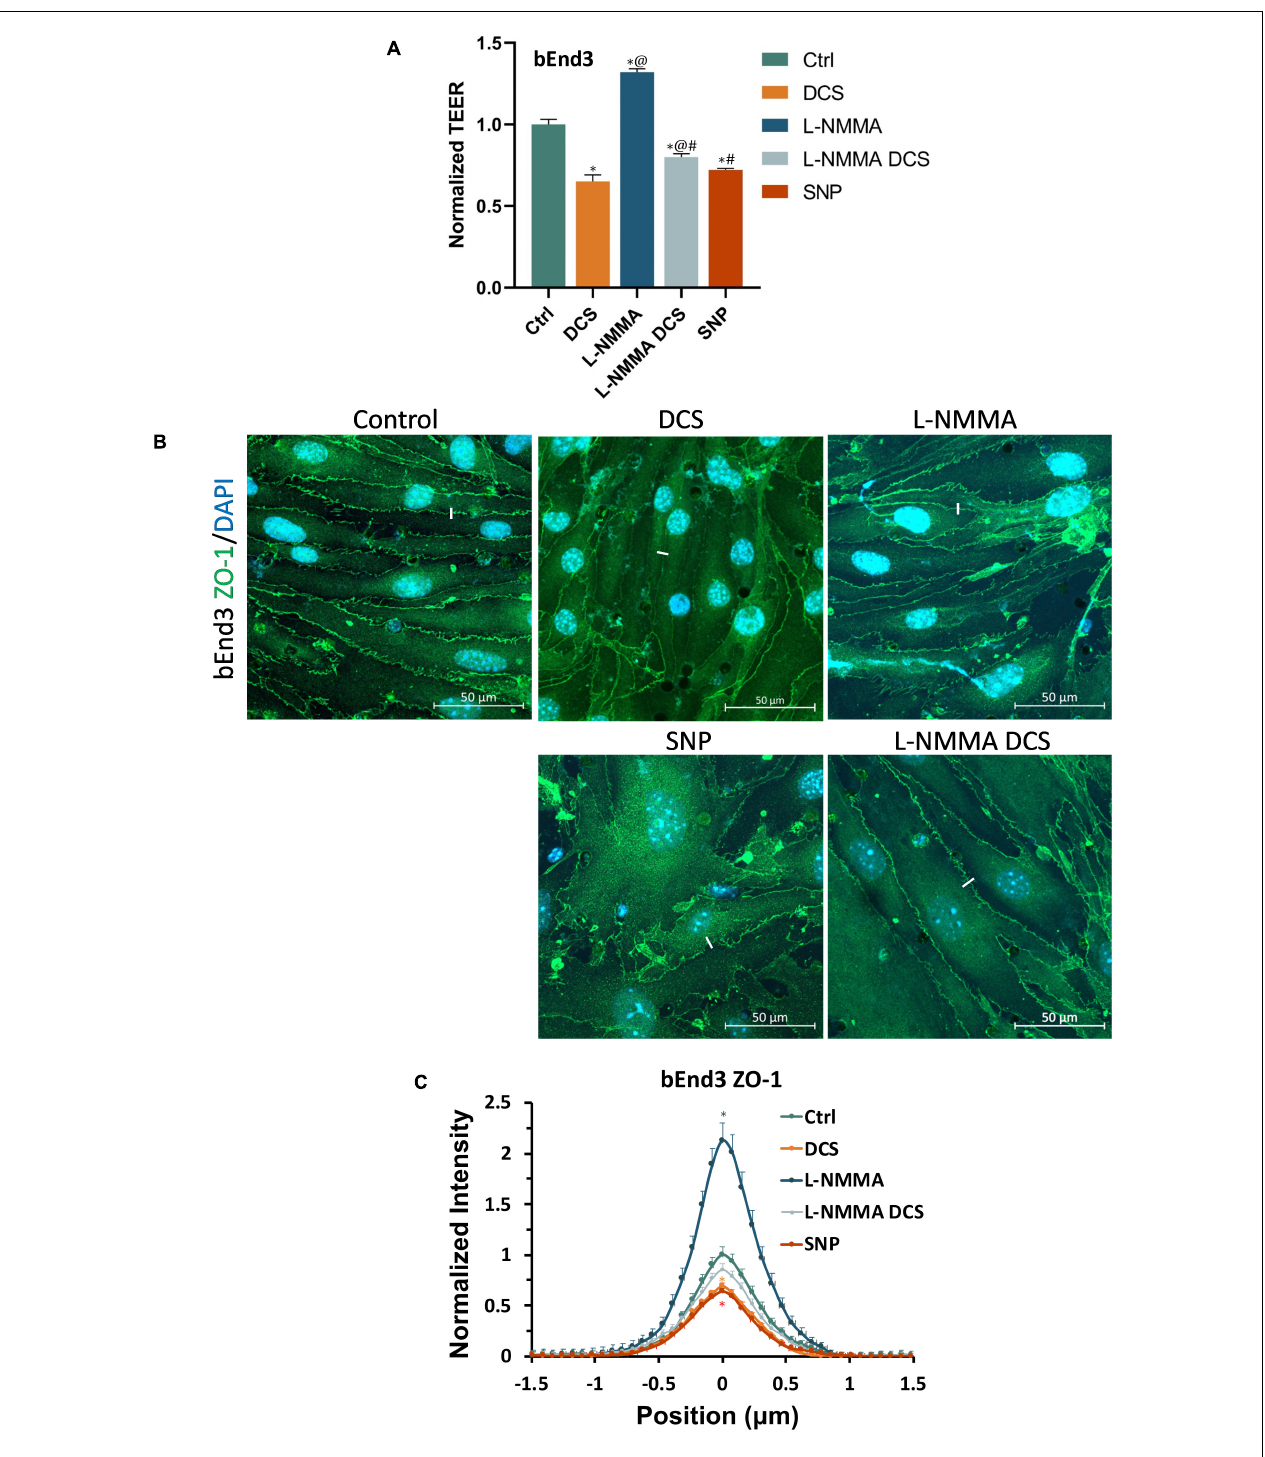
FIGURE 10 | Effects of a NOS inhibitor (L-NMMA) and a NO donor, sodium nitroprusside (SNP) on TEER and tight junction protein ZO-1 of in vitro BBB formed by bEnd3 monolayer. (A) Normalized TEER, (B) confocal images of ZO-1 of in vitro BBB, and (C) comparison of the intensity profiles of ZO-1 along a ∼ 3 µ m line perpendicular to the EC junctions (white lines in the confocal images) under control and after treatment of 10 min 1 mA/cm 2 DCS (DCS), or treatment of 60 min 1 mM L-NMMA, or pretreatment of 60 min 1 mM L-NMMA and treatment of 10 min 1 mA/cm 2 DCS (L-NMMA DCS), or treatment of 30 min 300 µ M SNP (SNP). n = 6 samples for each case in (A) and n = 3 samples for each case in (C) . * p < 0.05, compared with the control, @ p < 0.05, compared with DCS, # p < 0.05, comparing L-NMMA DCS and SNP with L-NMMA, % p < 0.05, comparing SNP with L-NMMA DCS.